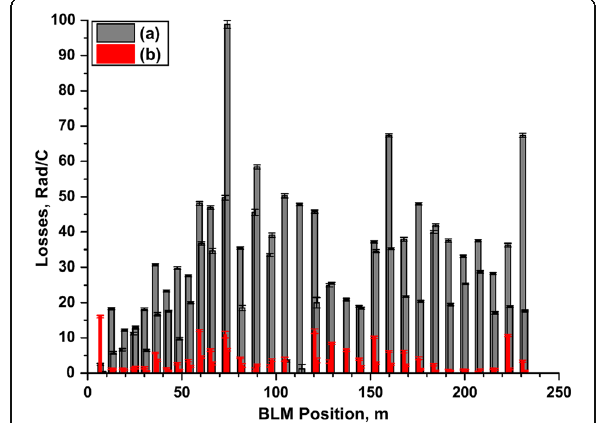
Fig. 7 Experimental results at the SNS linac; beam loss monitor signals (normalized by beam charge) for H − ( a ) and protons ( b ) along the SCL